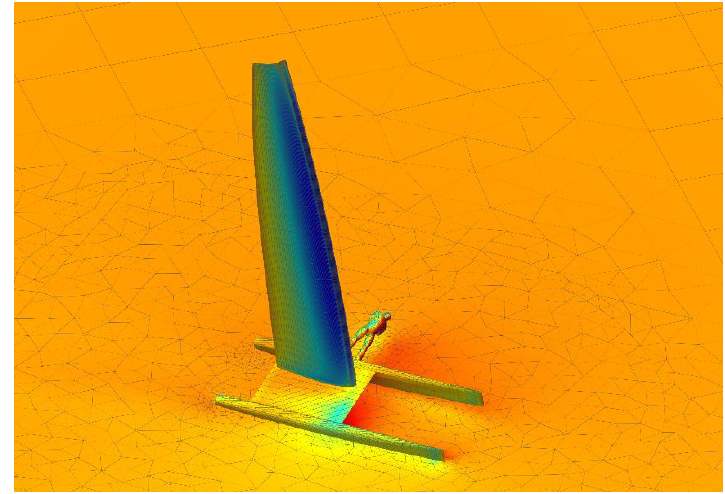
Figure 17. Final assembly of the Ansys Fluent computational domain.